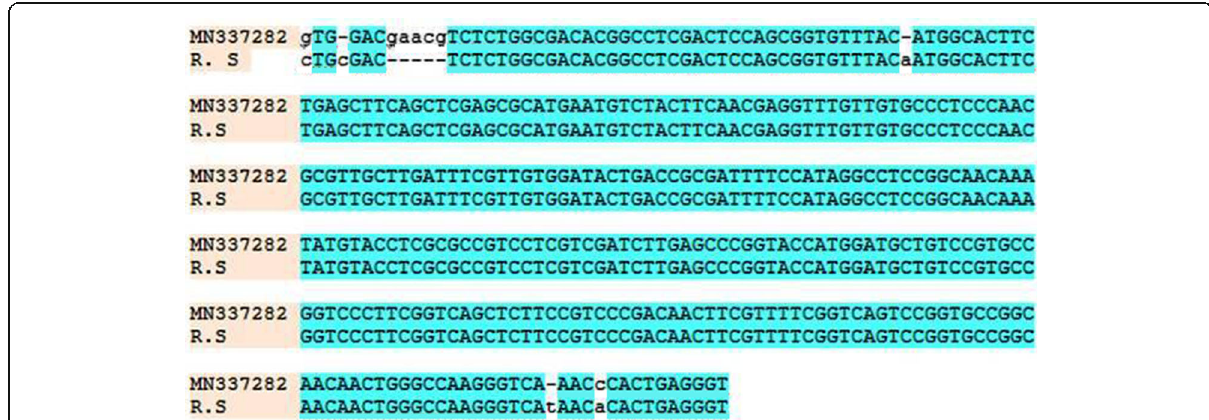
Fig. 4 Alignment of β - tubulin gene sequences from Beauveria bassiana and in B . bassiana treated rice plant. Identical positions are shadowed